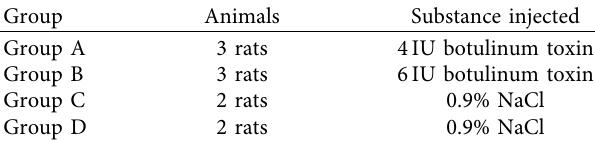
Table 1: Experimental and control